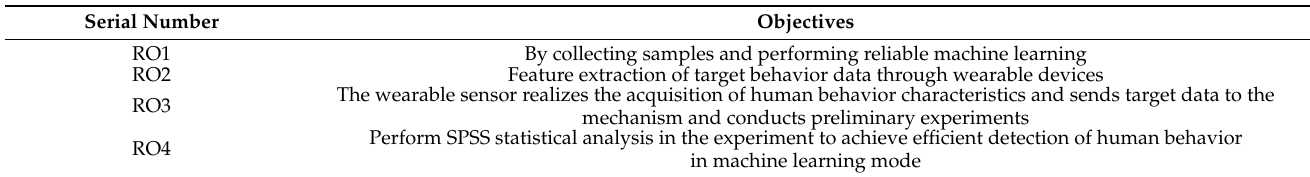
Table 2. Research